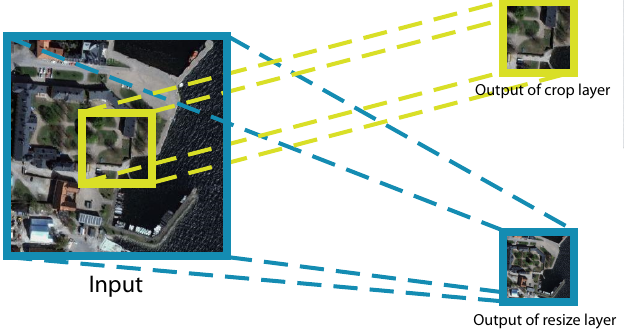
Figure 2. An illustration of the input/output of crop layer and the resize